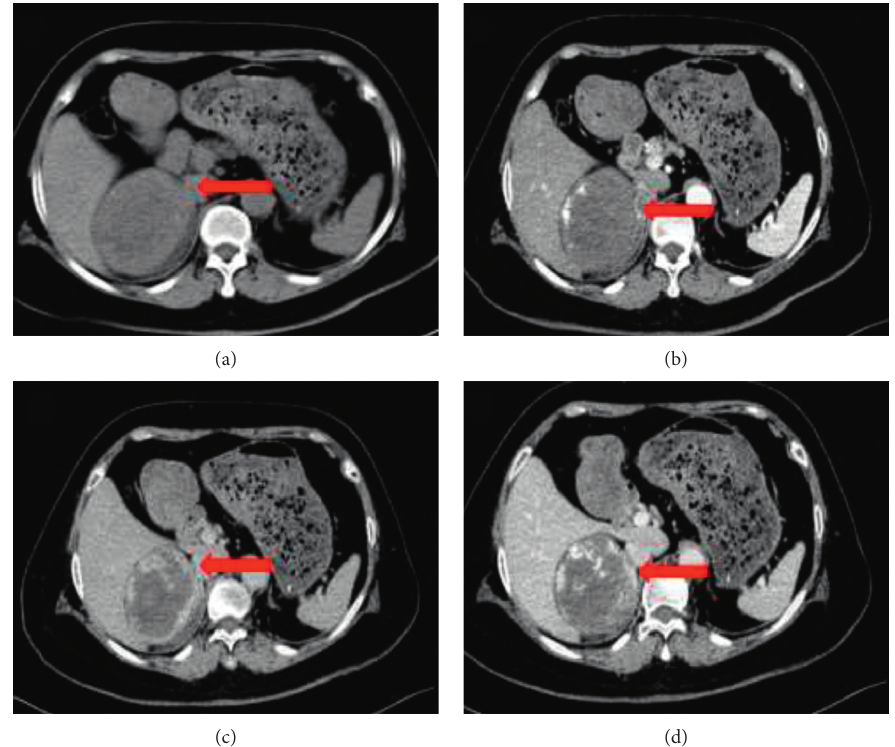
Figure 2: Right adrenal cavernous hemangioma with a tumor size of 8cm. (a) The unenhanced CT image. (b) Enhanced multiphase CT images revealing early peripheral nodular enhancement in the arterial phase (red arrow). (c), (d) Progressive partial filling-in (red arrow) in the venous phase and delayed